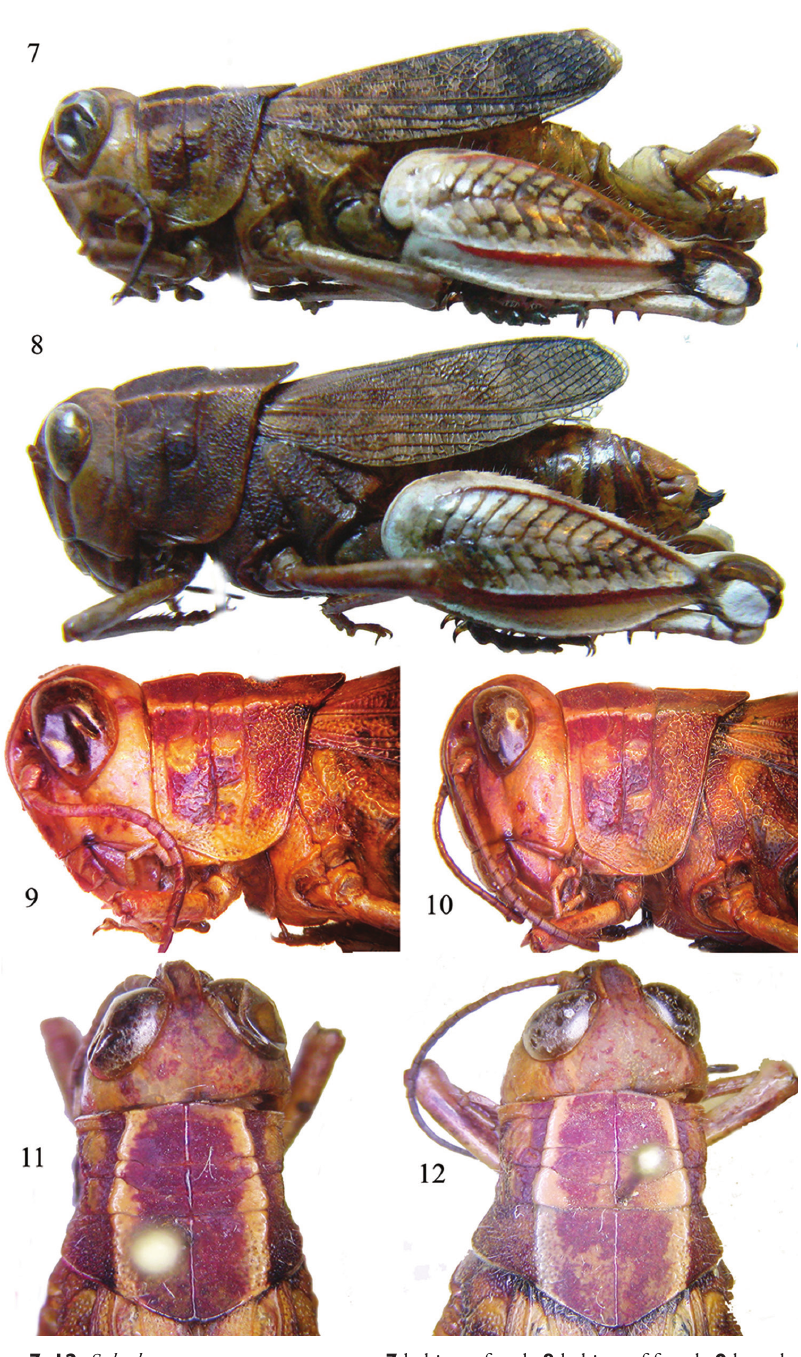
head and pronotum of male 10 lateral view of head and pronotum of female 11 dorsal view of head and pronotum of male 12 dorsal view of head and pronotum of